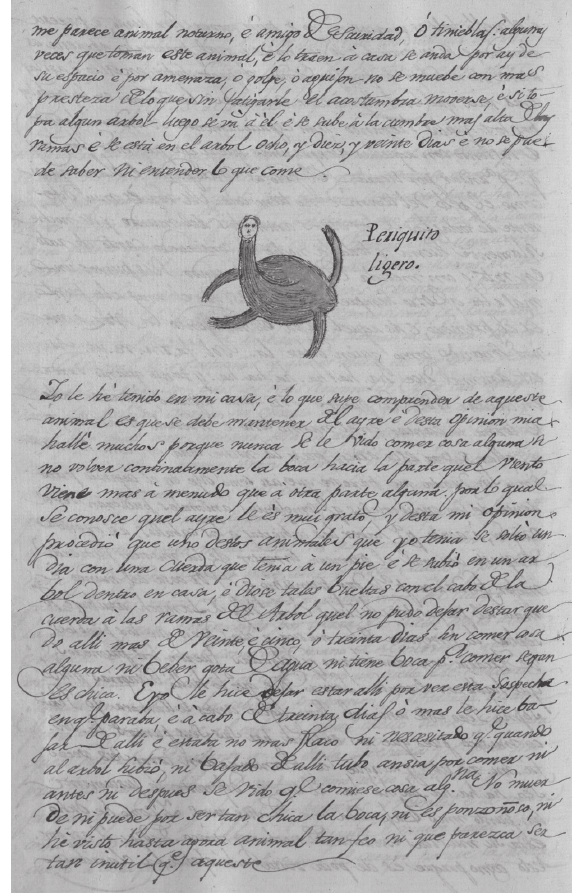
Figure 1 - 18 th century drawing of a sloth ( perico ligero or periquito ligero ). Juan Bautista Muñoz’s copy of Fernández de Oviedo’s “General and Natural History of the Indies” (M-RAH, 9/4786, folio 166 vº). Copyright: Real Academia de la Historia,